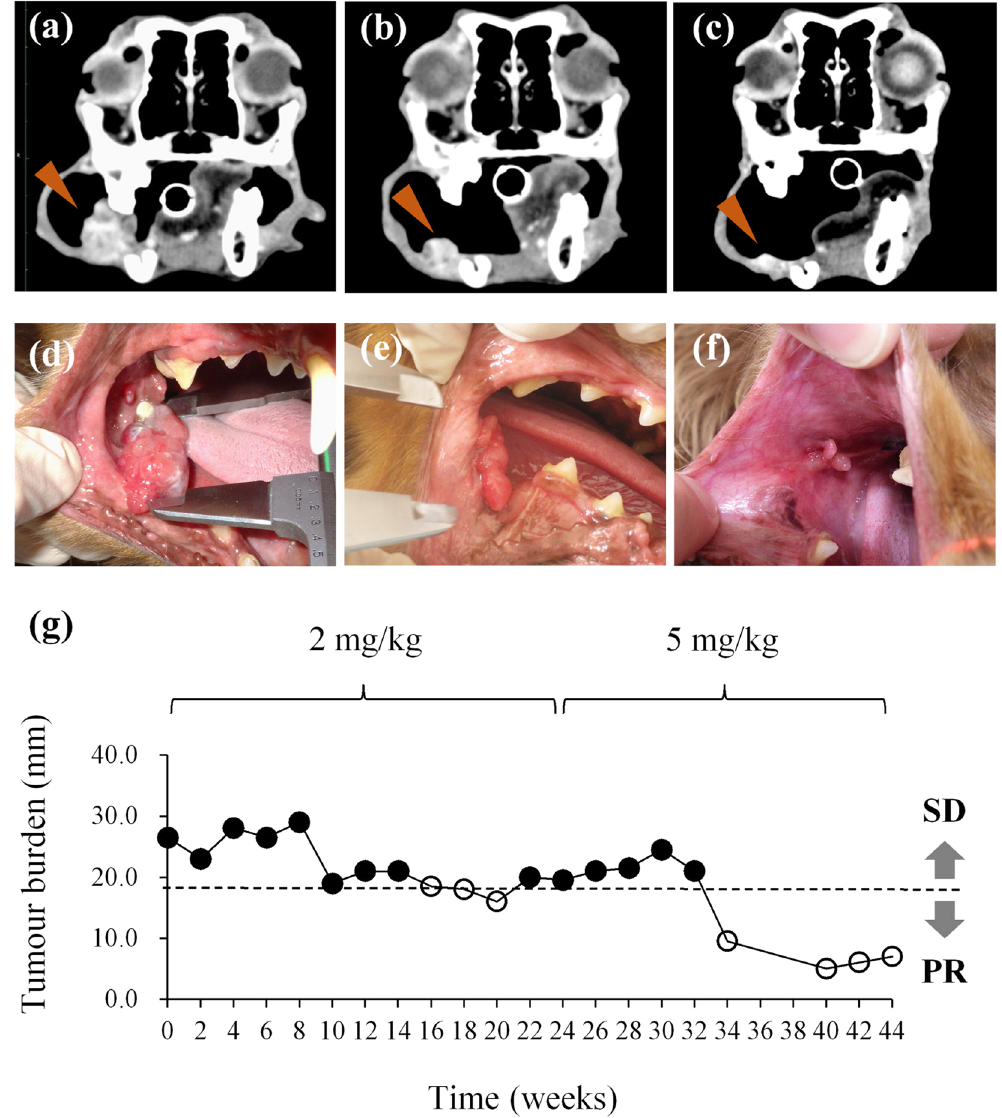
Figure 3. Antitumour effect of c4G12 in a dog with oral malignant melanoma. A dog with oral malignant melanoma was treated with 2 mg/kg (weeks 0–24) or 5 mg/kg (weeks 24–44) c4G12 every 2 weeks and the tumour burden was evaluated by gross examination and computed tomography (CT). ( a , d ) Tumour appearance at baseline (week 0). ( b , e ) Tumour appearance after 10 weeks of c4G12 treatment ( c , f ) Tumour appearance after 34 weeks of c4G12 treatment. Contrast-enhanced, and matched transverse CT images were shown. Arrowheads indicate the tumour lesions. ( g ) Changes in tumour burden. The longest diameter of target lesion was measured and recorded every 2 weeks. Reduction in tumour diameter by > 30% (time points indicated by open circles) was considered PR (partial response; see Methods for definition of